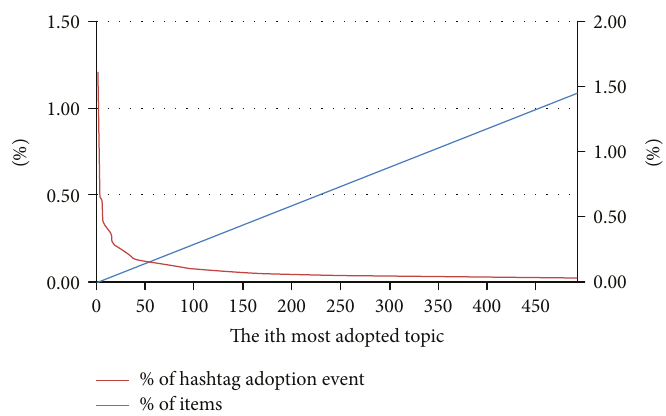
Figure 3: Short head and long tail of hashtag popularity distribution for top 33% hashtag adoptions in